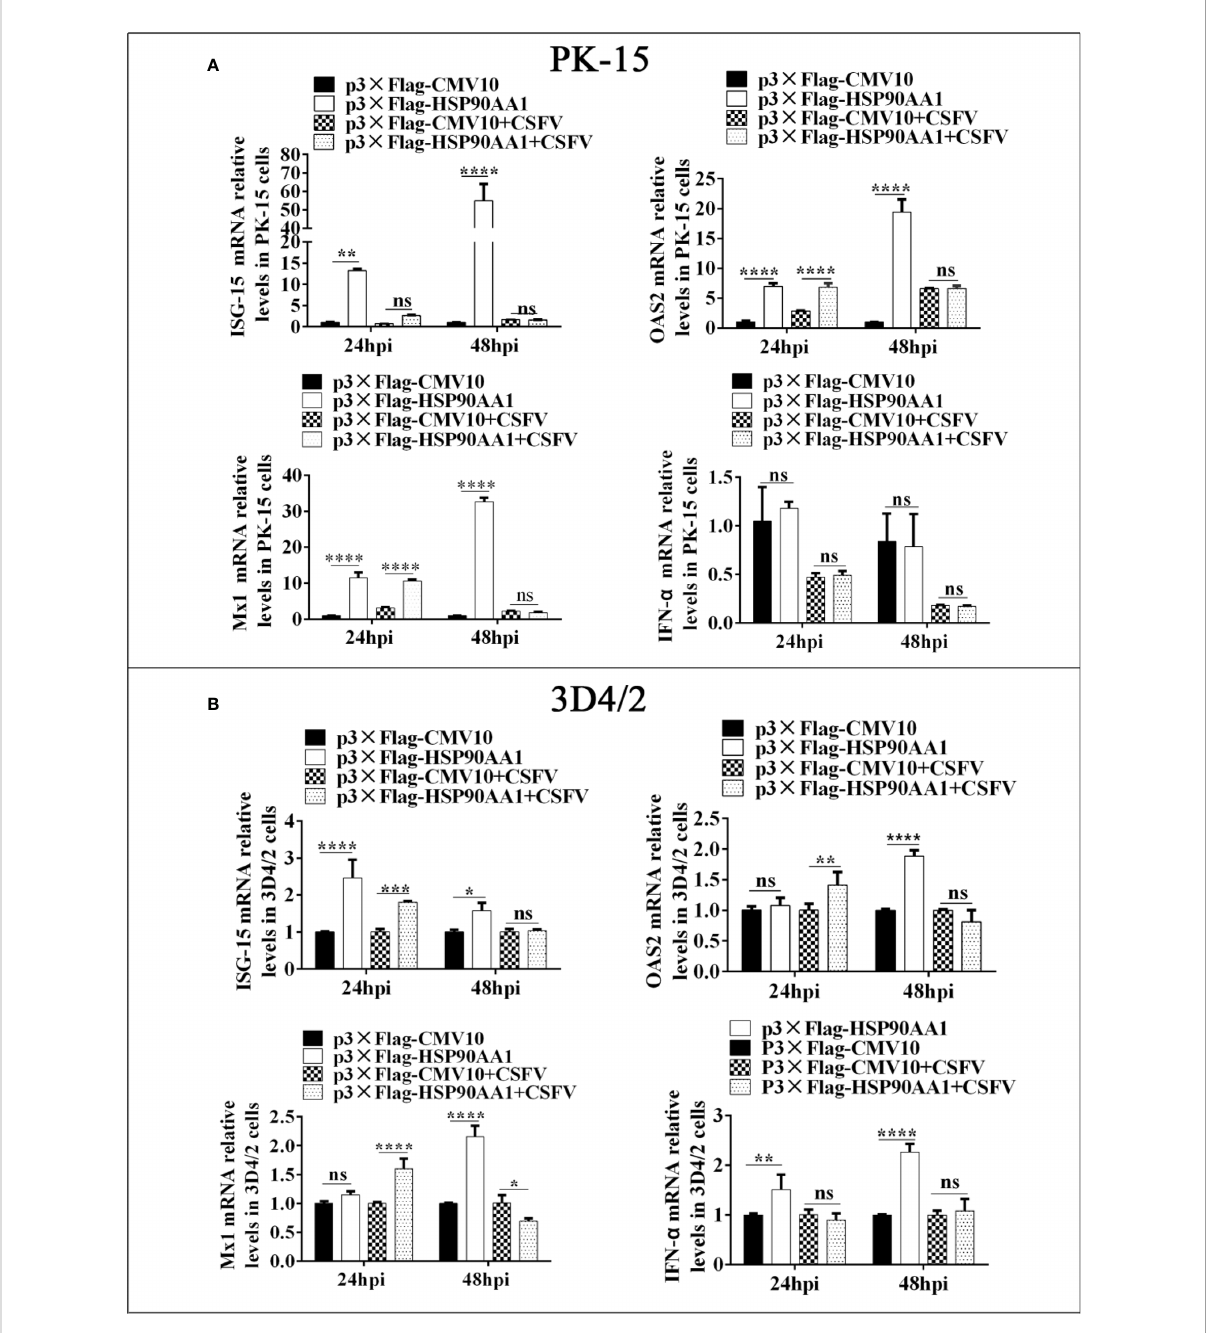
FIGURE 7 HSP90AA1 over-expression does not promote the expressions of ISGs and IFN- a under CSFV Infection. (A, B) Relative mRNA levels of ISGs and IFN- a in PK-15 and 3D4/2 cells were determined by RT-PCR. Cells were transfected with p3×Flag-HSP90AA1 fi rst and then infected with CSFV (MOI=1). Cells were harvested at 24hpi and 48hpi. Total cellular RNA was extracted to determine relative mRNA expression levels of ISGs and IFN- a . (*p < 0.05, **p < 0.01, ***p < 0.001 and ****p < 0.0001 calculated using two-way ANOVA, ns, not signi fi